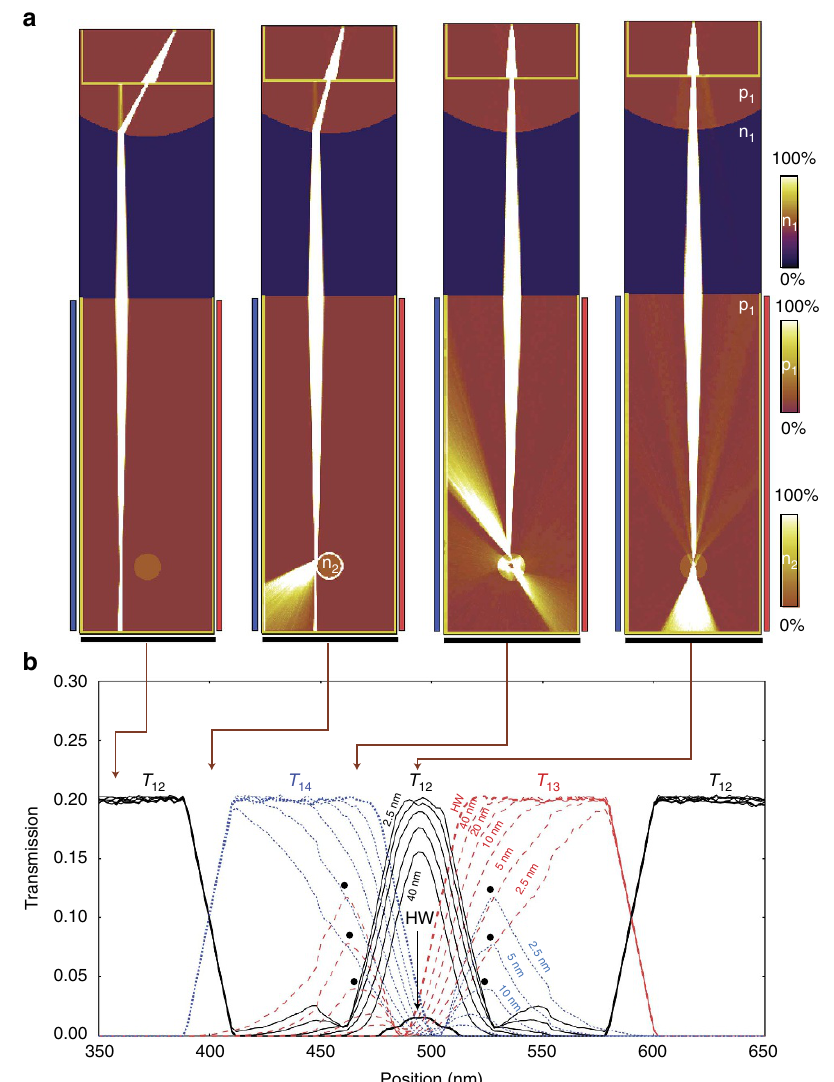
Figure 6 | Imaging of VDs with different smoothness. ( a ) Current density plots in a 1 (cid:4) 4.5 m m DFM with 200nm diameter VD targets for four different magnetic fields, indicated with arrows in the panel b below. The width of the p–n junctions is w ¼ 10nm. ( b ) Development of transmission image for VDs with different width ( w ¼ 2.5, 5, 10, 20 and 40nm), as well as hard-walled, reflective potential (HW), for the four magnetic fields simulated in a . The dotted, blue curves correspond to the transmission T 14 , for electrode 4, whereas the dashed, red curves represent the transmission T 13 , for electrode 3. The black, full curves show the transmission T 12 between electrode 1 and the backplane electrode 2. Although the zero-incident angle peak (at 500nm) does not change significantly with w , the transmission side-bands caused by caustic jets, at 400–500nm and 500–600nm, changes dramatically from w ¼ 2.5nm to w ¼ 40nm (marked with black